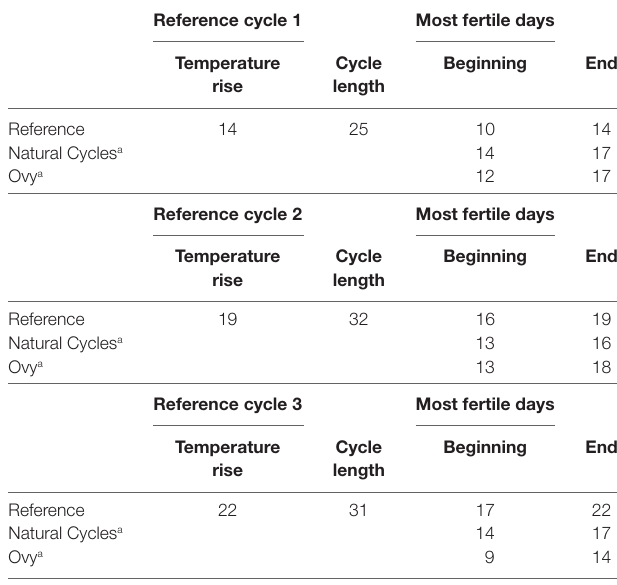
Table 4 | Predicted most fertile days in relation to cycle length/temperature rise.